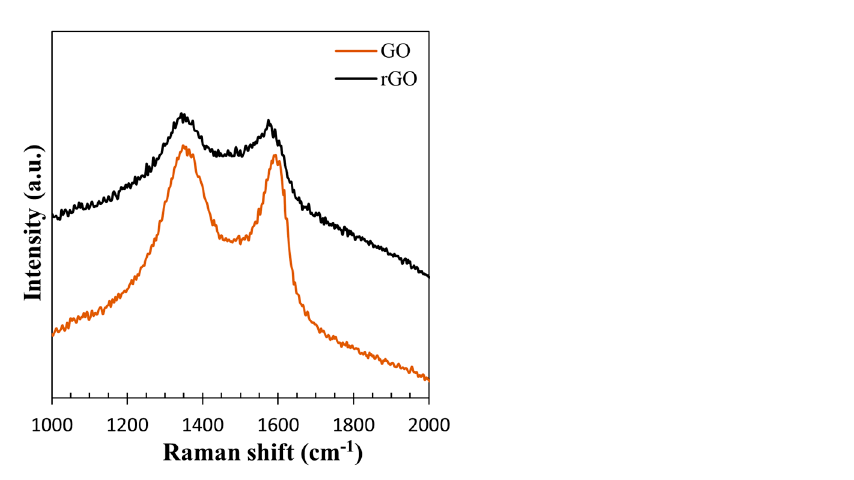
Figure 10. TGA curves of GO and rGO synthesized using lemon juice (heating rate = 10 o C /min, N 2 flow).